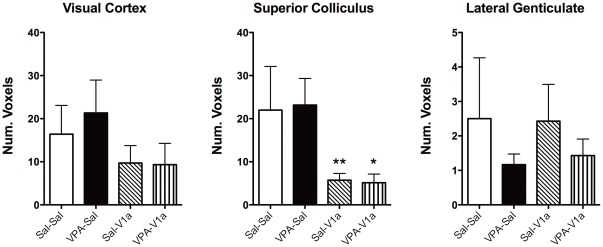
Number of voxels in visual pathway regions of rats pre-exposed to saline and VPA during gestation.The study design is as explained in Figures 4 and 5. Sal and VPA rats were subdivided into animals that were given an ICV injection of Sal or a vasopressin V1a receptor antagonist. The groups are: Sal-CSF (open bar), VPA-CSF (close bar), Sal-V1a (diagonal patterned), and VPA-V1a (upward patterned). VPA treatment did not have the same effect on the visual stimulus as with the social stimulus (VPA-CSF versus Sal-CSF). V1a receptor blockade reduced voxels in superior colliculus, an area containing a moderate density of V1a receptor mRNA [19], in both Sal and VPA rats. Data shown as mean ± standard error. Data shown as mean ± standard error. Asterisks indicate specific posthoc comparisons with * p<0.05 and **p<0.01 (two way ANOVA).